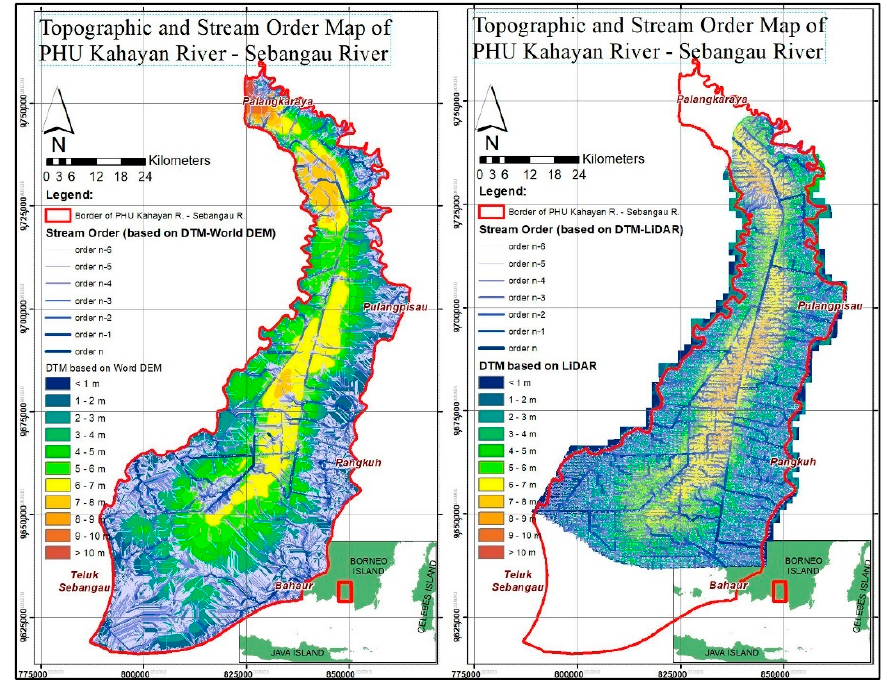
Figure 2. The pattern of surface water flow on peatland in the Kahayan–Sebangau PHU derived from DTM filtered from WorldDEM ( left ) and DTM filtered from LiDAR ( right ). (data source: BRGM-RI, and processed by the authors).